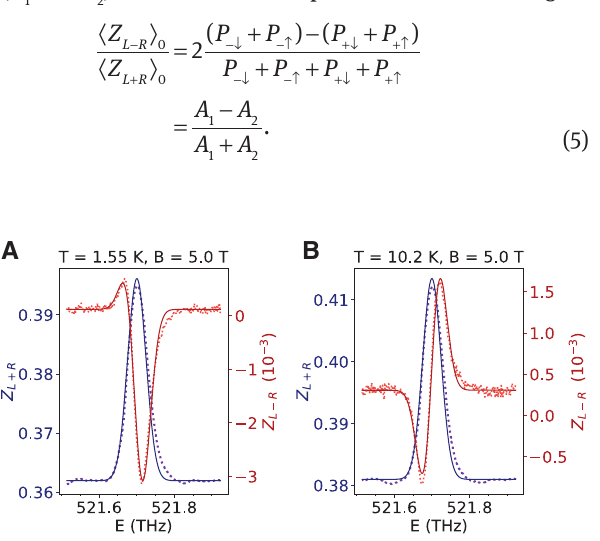
Figure 2: Examples of MCD